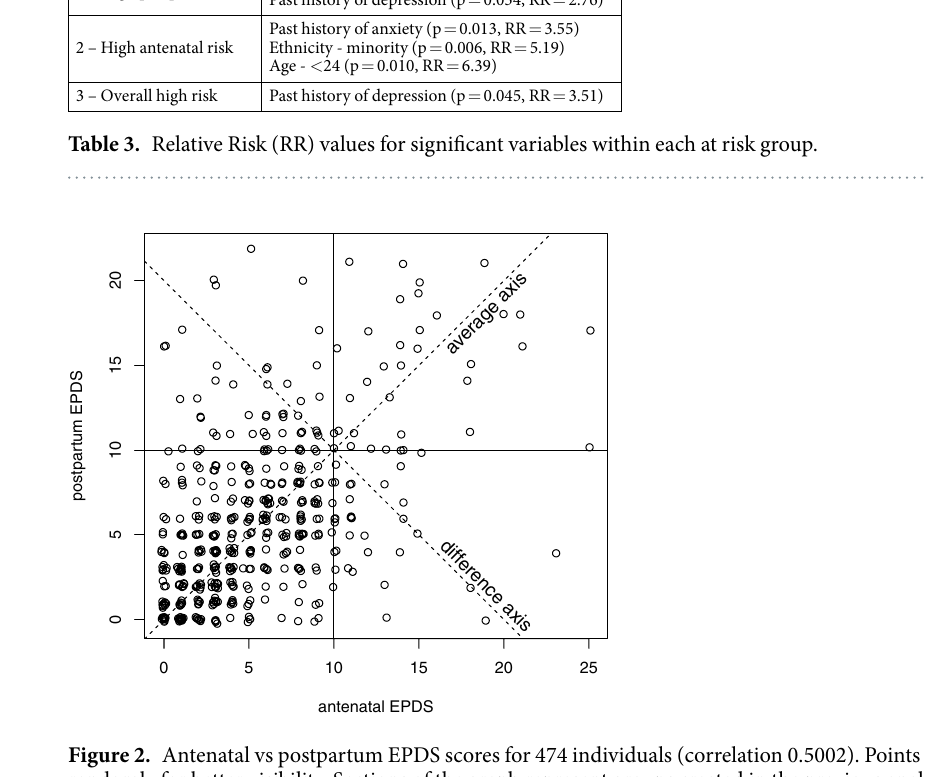
Figure 2. Antenatal vs postpartum EPDS scores for 474 individuals (correlation 0.5002). Points are jittered randomly for better visibility. Sections of the graph represent groups created in the previous analysis.